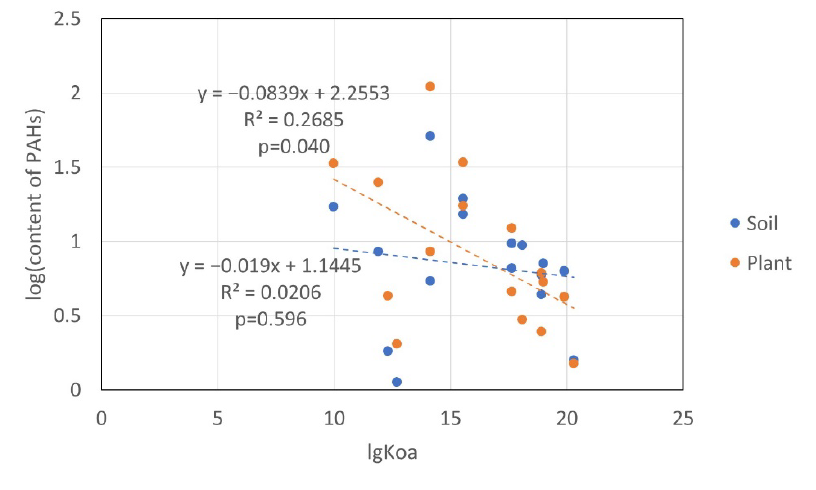
Figure 10. Relationship between the PAH contents and